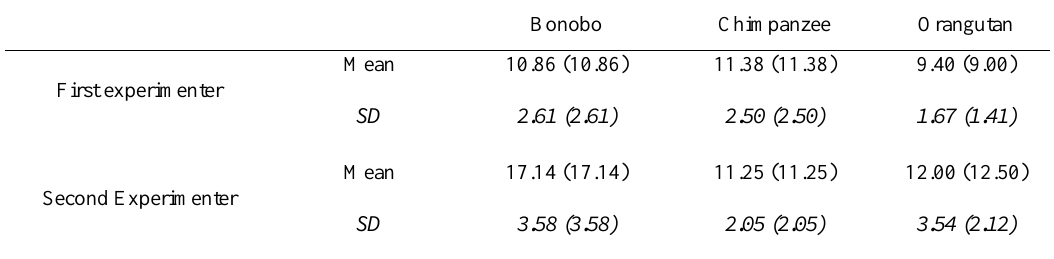
Mean Number of Sessions Needed to Complete Training with the First and Second Experimenter by